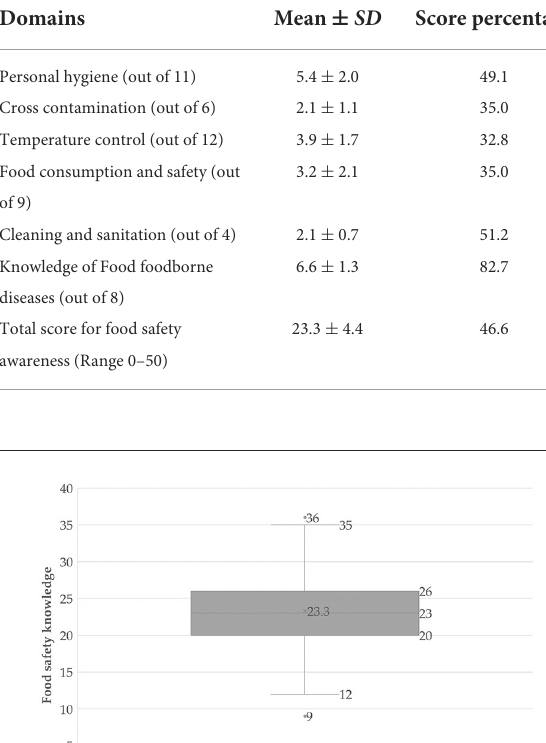
TABLE 1 Socio-demographic characteristics of the study participants ( n = 325).